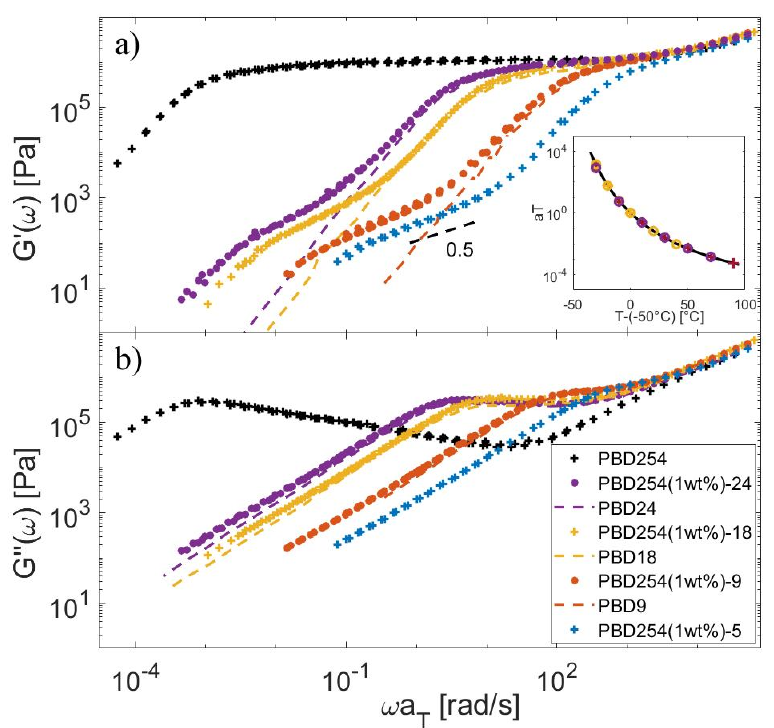
Figure 3. Storage ( a ) and loss ( b ) moduli shifted to T ref = − 50 ◦ C, for the PBD254-Matrix blends (symbols) and for the short chain matrix in the monodisperse state (dashed line). Insert: corresponding shift factors.